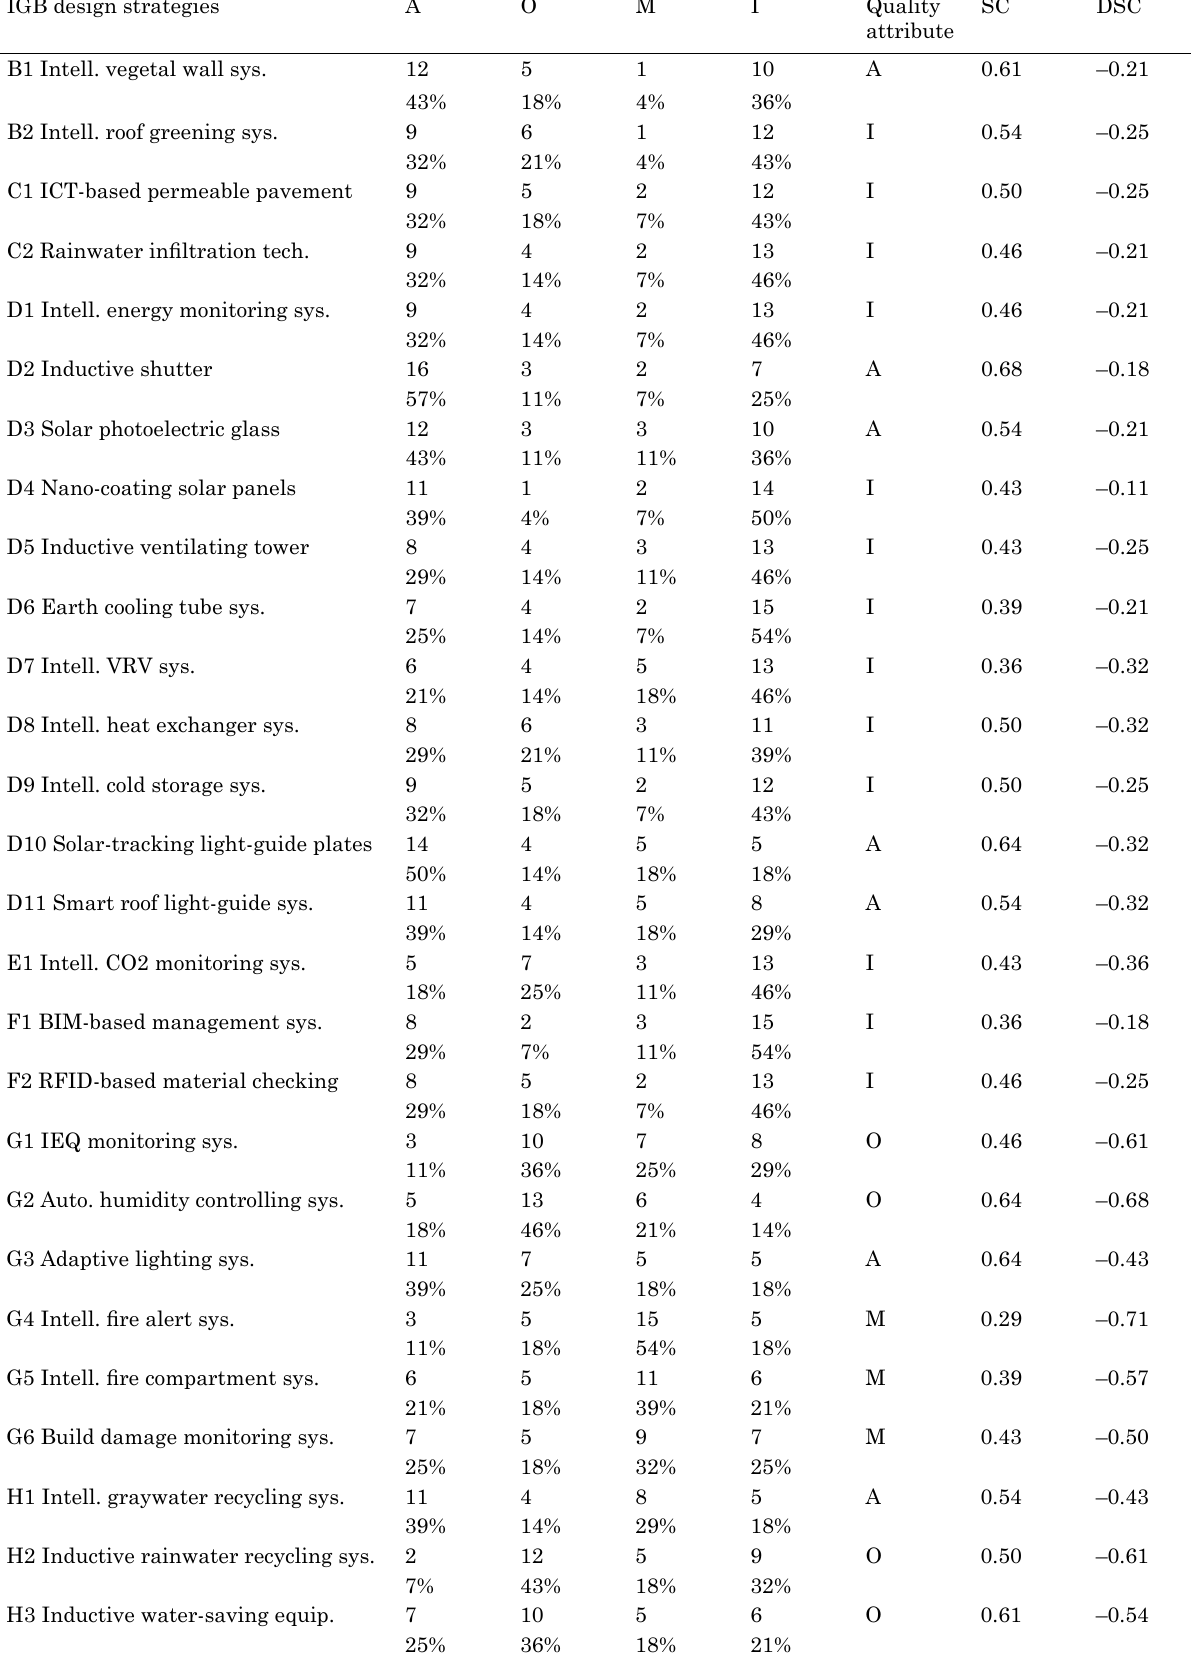
Table 4. Quality attribute and satisfaction coefficient of general users IGB design strategies B1 Intell. vegetal wall sys. B2 Intell. roof greening sys.